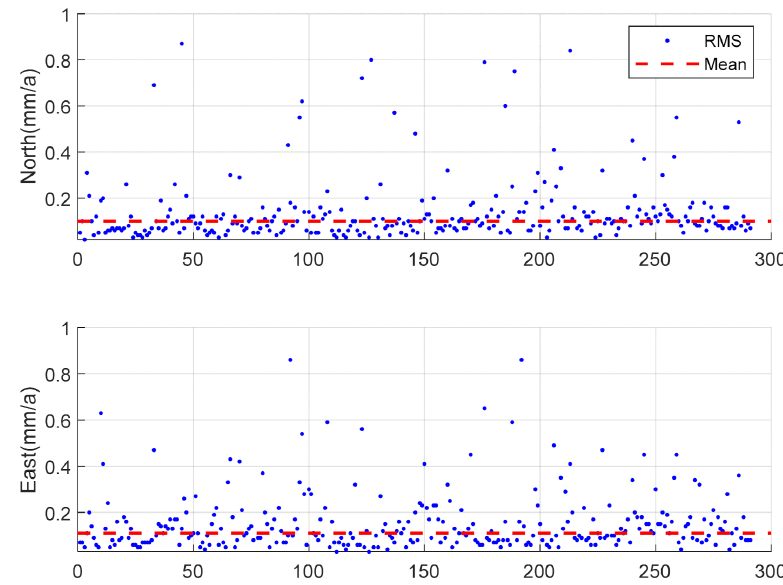
Figure 5. The RMS of the horizontal velocity field in continental